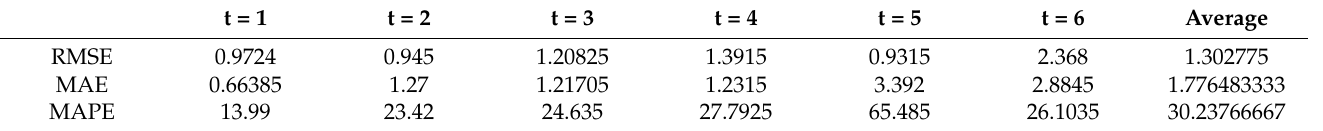
Table 13. Performance results of different univariate hybrid WSP models for Arizona Hills